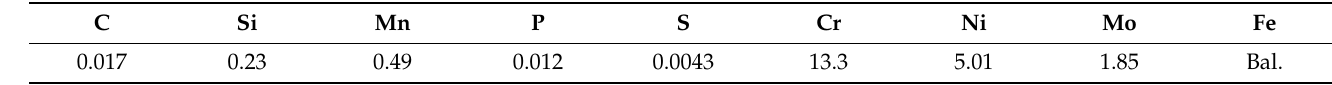
Table 1. The chemical composition of Super 13Cr